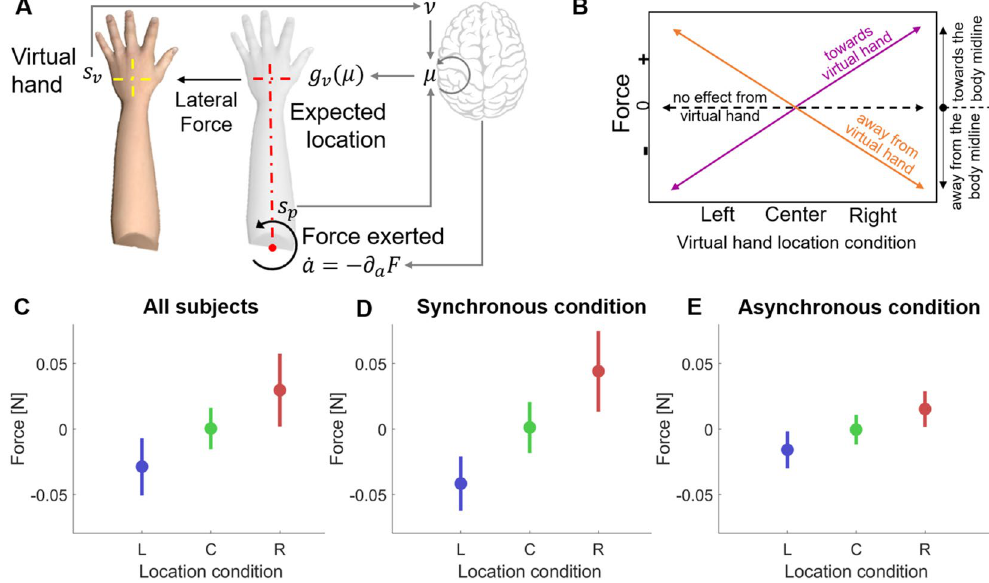
Figure 2. Computational model predictions. ( A ) Arm model description with one degree-of-freedom (DOF) and the VR hand as the visual input. Using the proprioceptive input s p (joint angle) and the prior information of the body state p (µ) the model predicts the expected location of the hand g v (µ) . However, the visual information (virtual hand, s v ) manipulated to appear in a different location produces a sensory conflict: my hand is not at the predicted location. Thus, producing an error that is propagated and generates the perceptual drifts and the active component. According to our hypothesis, the torque direction corresponds to reducing the prediction error: expected hand location minus the VR location. ( B ) Relation between the direction (sign) of the predicted force and the virtual hand location. Our model predicts a trend similar to the one shown by the purple line, e.g., negative force in the left condition implies that the attempted force is towards the virtual hand. ( C ) Mean and standard deviation of the predicted force with the active inference model for Left, Center and Right conditions. ( D ) Model predicted mean force for the synchronous condition. ( E ) Model predicted mean force for an ideal asynchronous